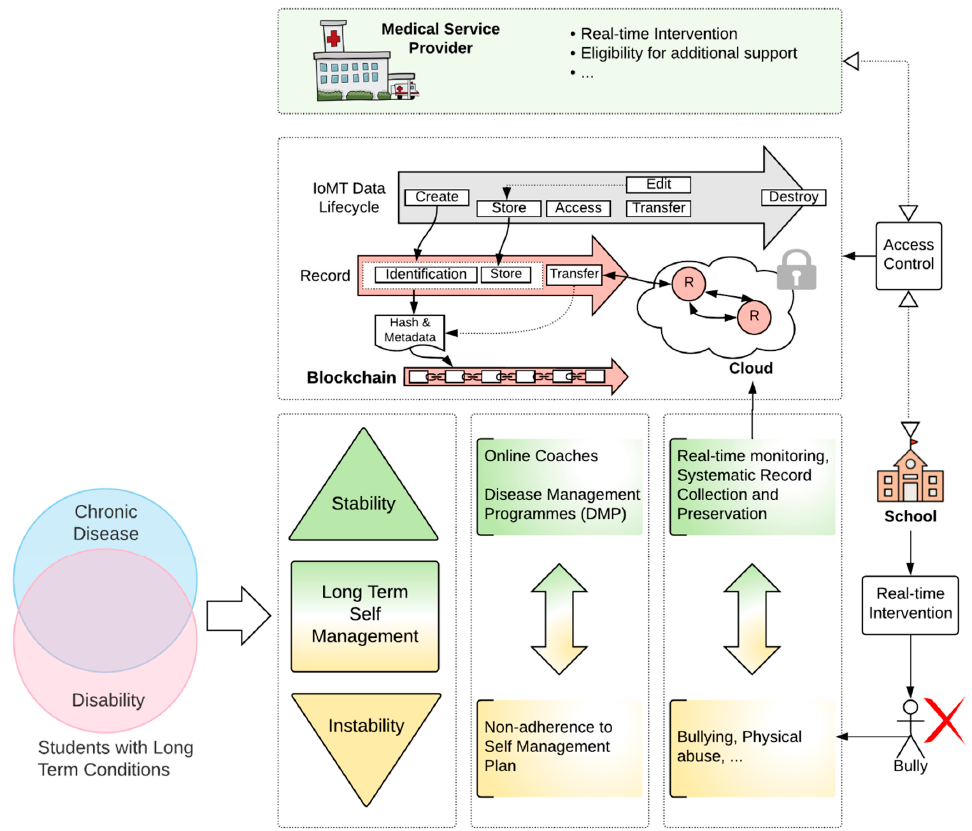
Figure 2. Real-time analysis of IoMT data to monitor the well-being of patients is extended to facilitate on-campus intervention by schools against physical abuse. The model can be generalised to other stakeholders if they joined the private permissioned blockchain.